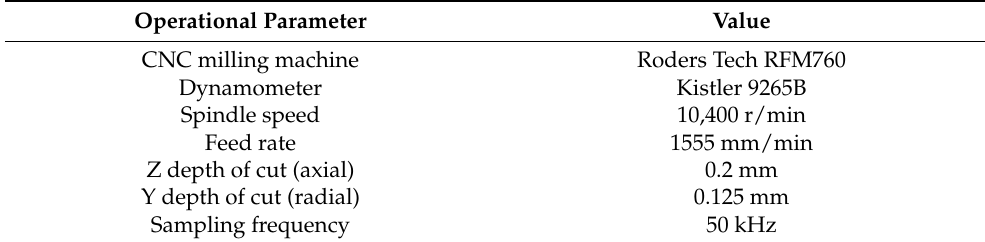
Figure 2. High-speed milling machine tool wear monitoring experimental platform. Table 1. Experimental hardware and milling conditions.